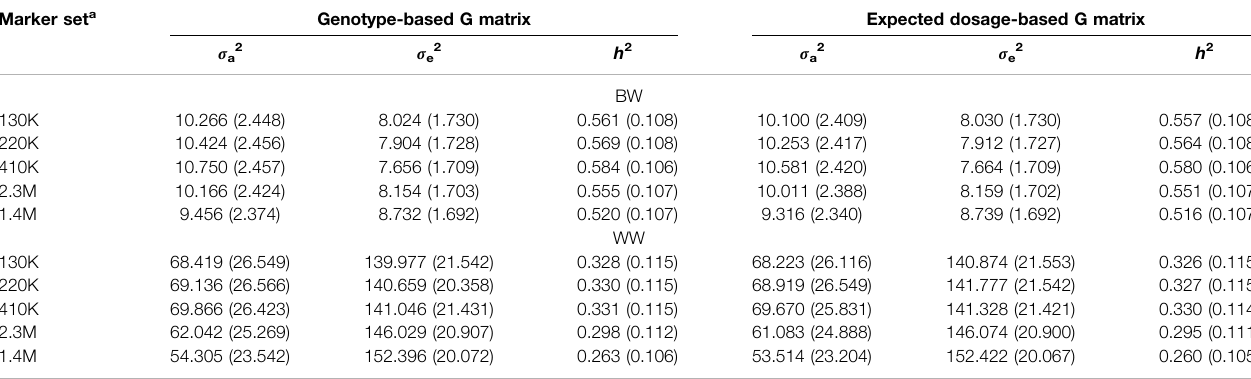
TABLE 1 | Estimates of variance components and heritabilities and their standard errors (in brackets) under single-trait model using different marker sets and different G matrices for birth weight (BW) and weaning weight (WW). Marker set a